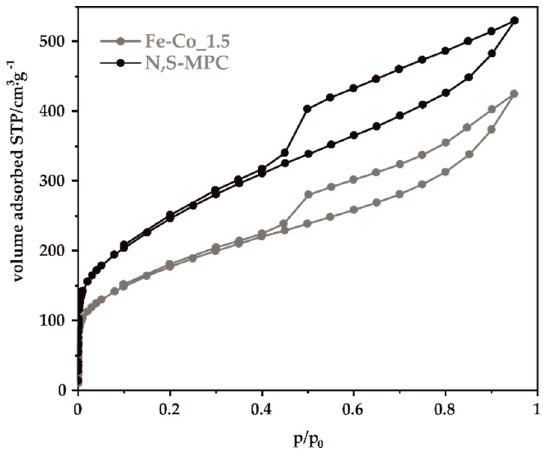
Figure 1. The N 2 -sorption isotherm for the N,S-MPC support and Fe-Co_1.5 samples.